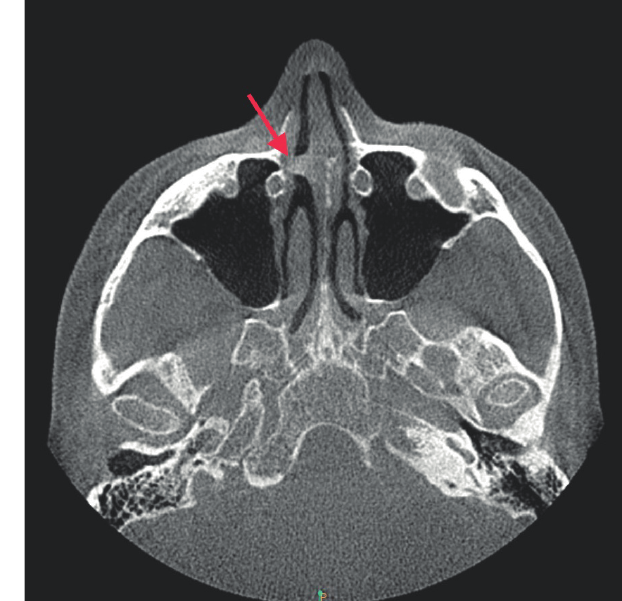
Figure 1. Non-contrast coronal computed tomography (CT) image show- ing a right nasal septal mass (depicted by the red